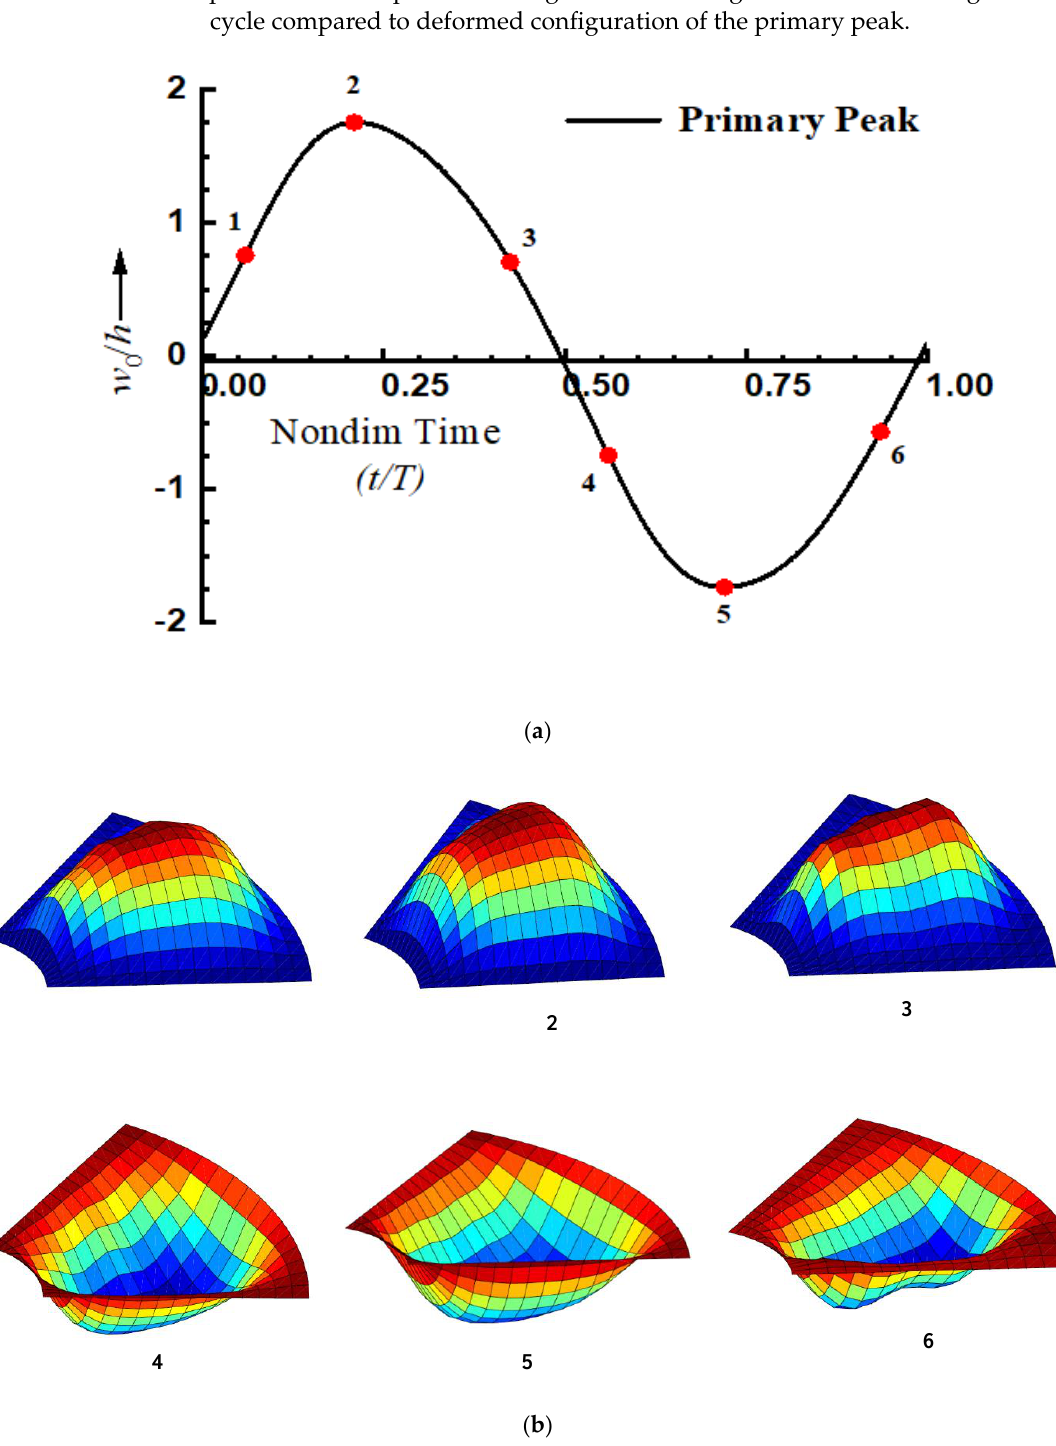
Figure 10. ( a ) Non-linear steady state response corresponding to primary peak amplitude (Point A) of Figure 6 at the center of the plate for ϕ = 120° and ( b ) the corresponding deformed configurations at different instants.